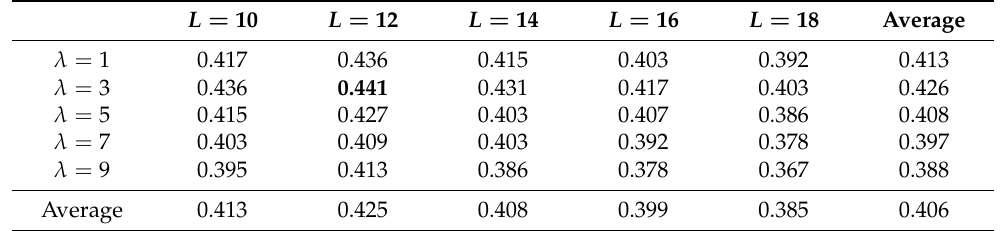
Table 4. Average F-measure of Tl-LVM for all games when parameters λ and L of the Poisson distribution are changed. Bold values represent the highest F-measure. L = 10 L = 12 L = 14 L = 16 L =